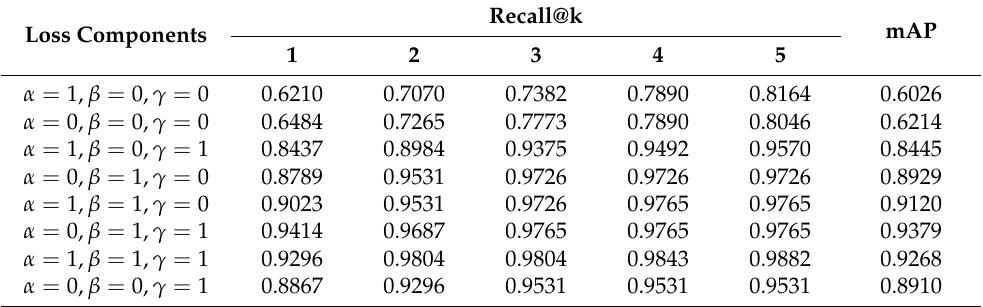
Table 5. Recall@k and mAP comparison between using different loss function settings of ViT model. Loss